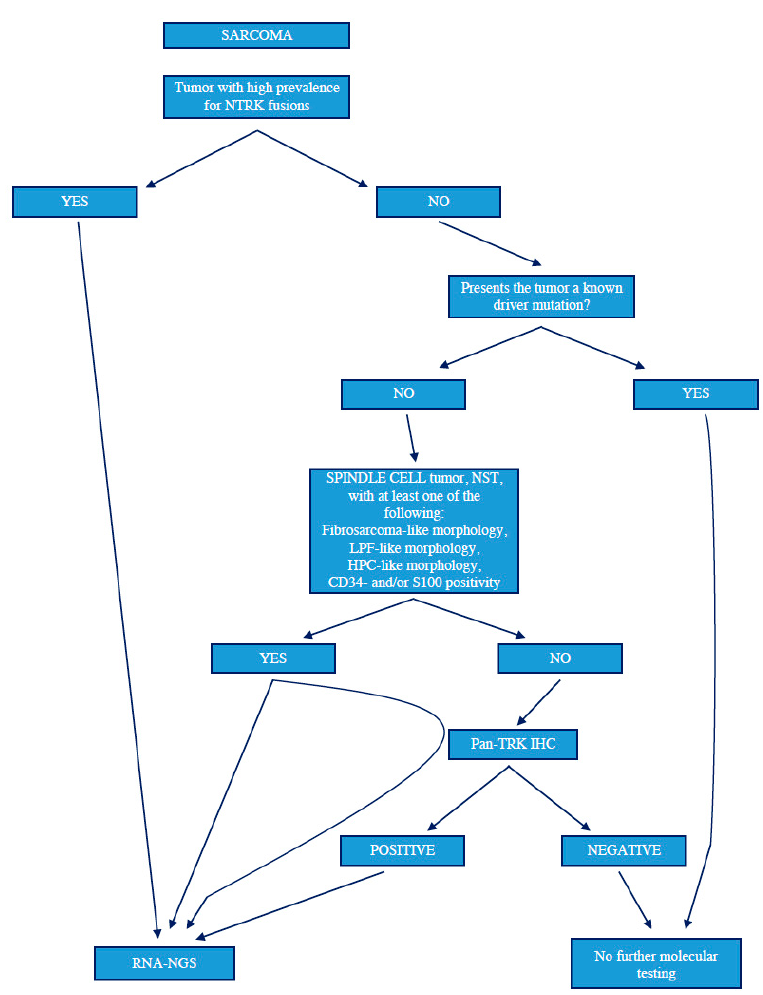
Scheme 1. Diagnostic algorithm for the identification of NTRK fused sarcomas, according to